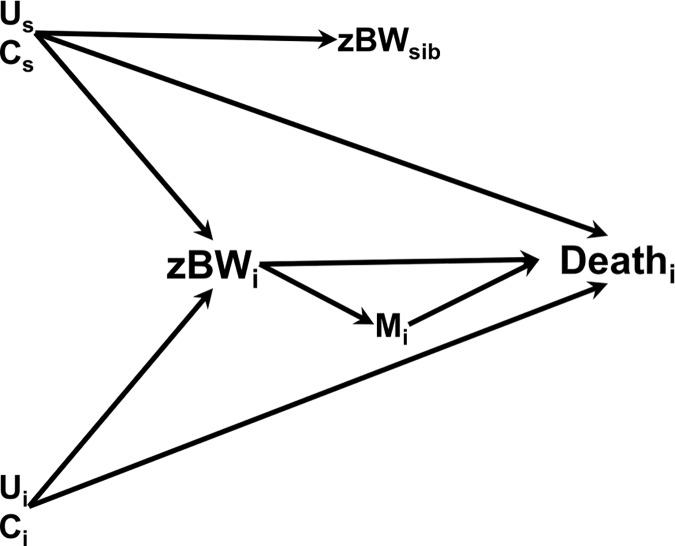
Causal diagram illustrating the relation between perinatal death and birth weight.zBW: z-score birth weight, standardized for year of birth, sex, birth order, gestational week, and plurality.Subscripts: i relates to index infant (participant); s relates to shared family factors; sib relates to sibling(s).U: Unmeasured confounders. Us are shared factors in the family, e.g., genetic factors, stable maternal health or metabolic characteristics, stable socioeconomic characteristics. Ui are individual factors, e.g., placental function, pregnancy-specific maternal health or metabolic characteristics, socioeconomic characteristics changing across pregnancies.C: Measured confounders. Cs: mean sibship zBW (zBW of all mother’s births), paternity, number of infants in sibship; Ci: birth defect, preeclampsia, maternal age, maternal marital status, maternal diabetes, and maternal chronic disease.Mi: Individual mediating factors (e.g., instrumental delivery procedures, prolonged labor, or birth injuries) whereby zBWi could cause perinatal death among infants who were alive at start of the birth.